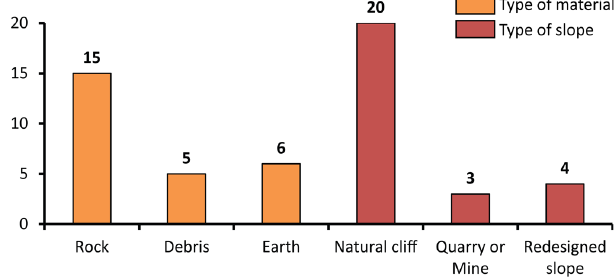
Fig. 1. Type of landslide materials and slopes involved in this study. The total number is over 23, due to multiple possible settings.